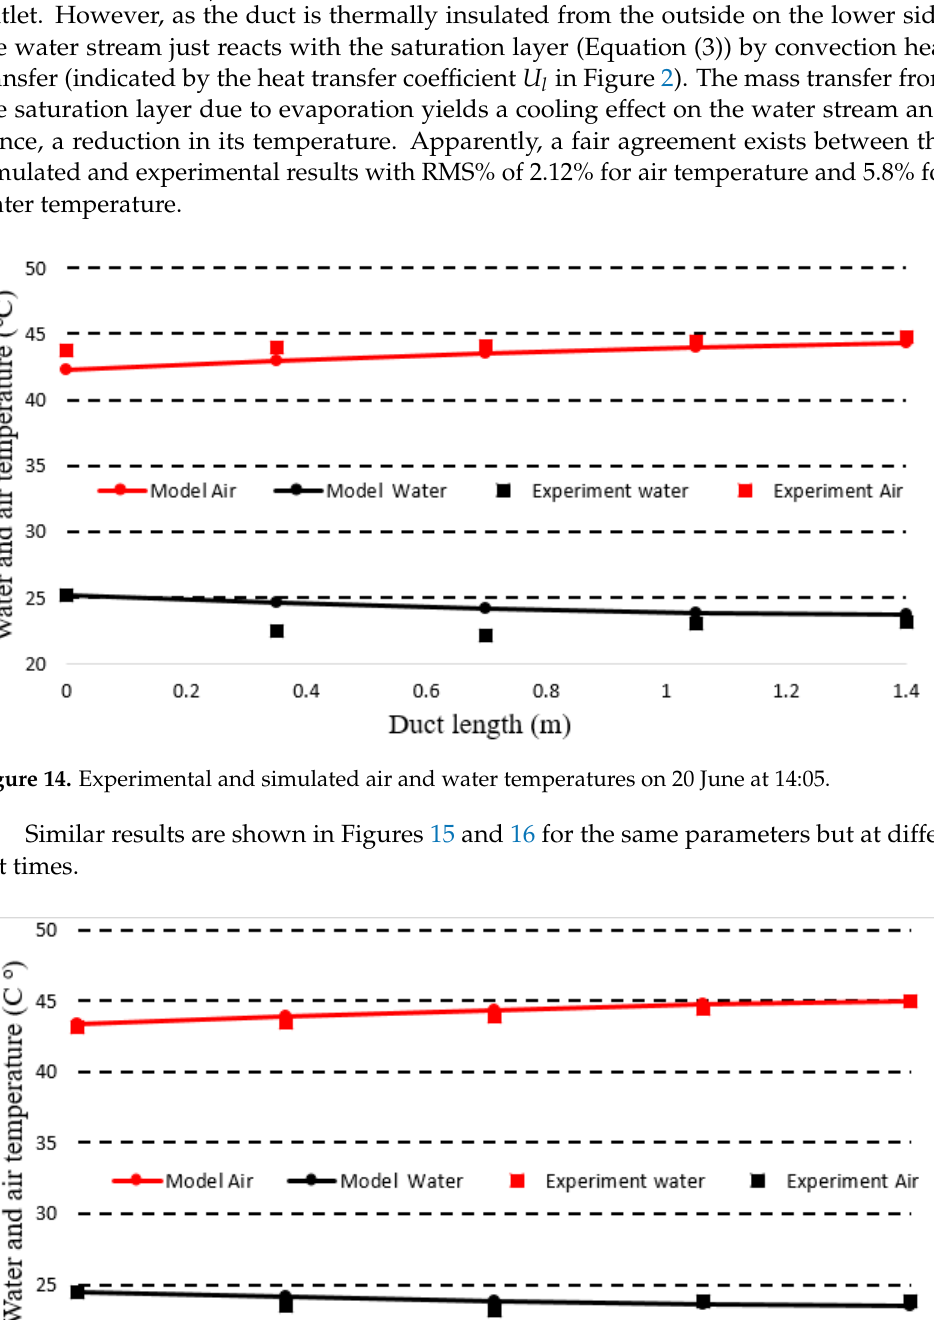
Figure 13. Experimental and simulated cooled and reference PV temperatures on 20 June.